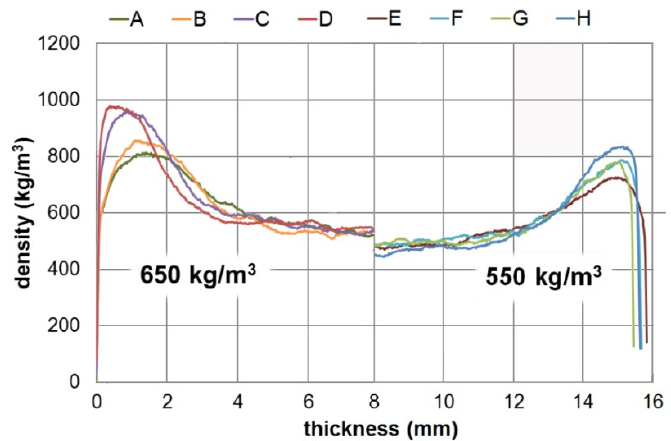
Figure 2. Density profile of manufactured particleboards.